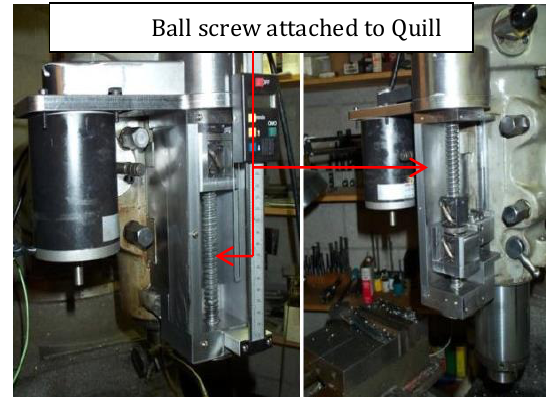
Source : Hugh Currin